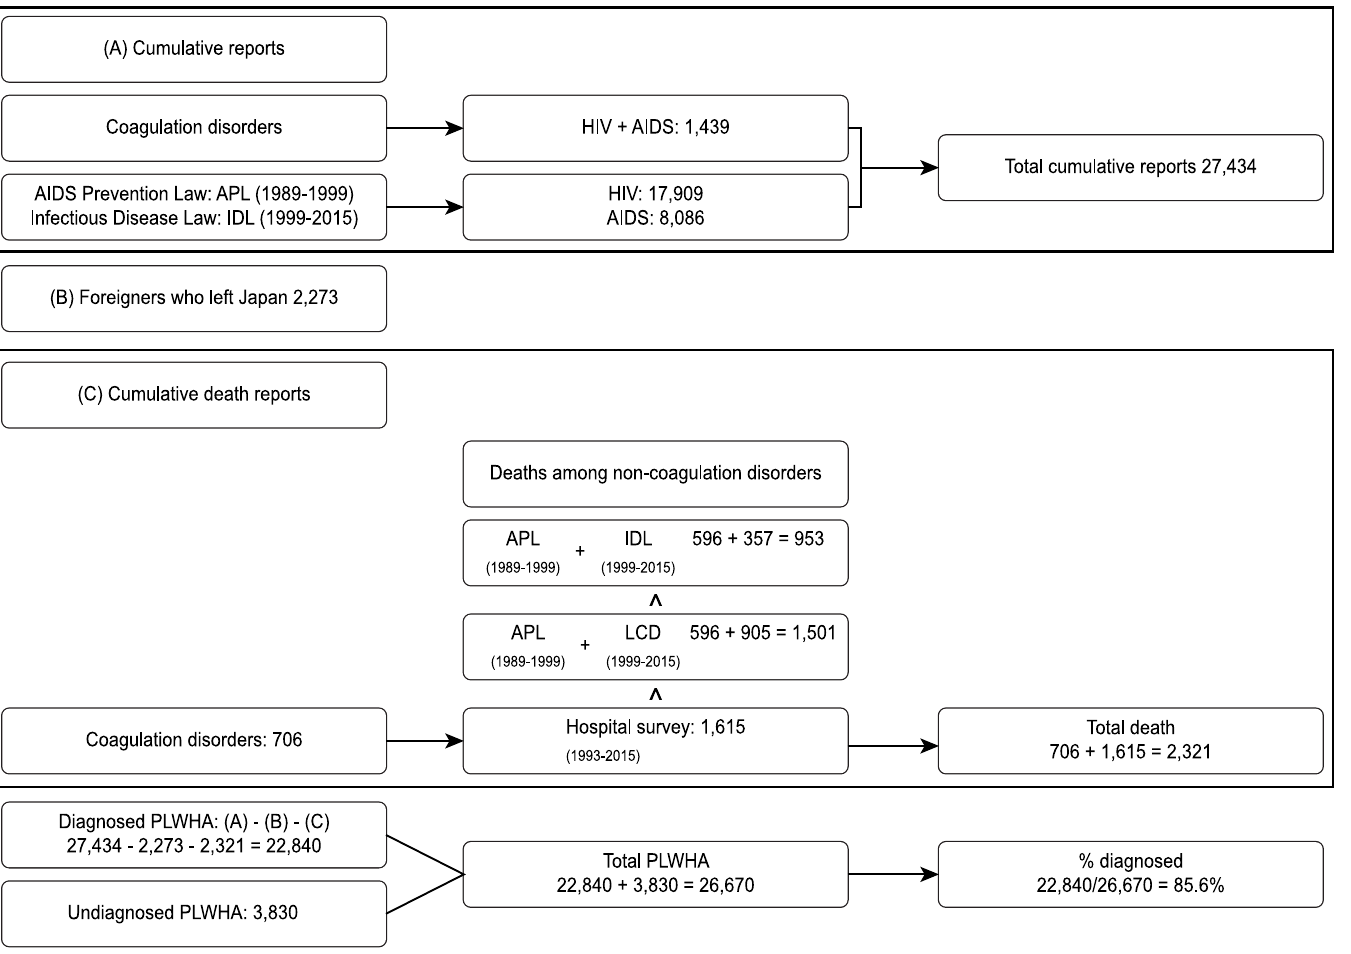
Fig 1. Estimation of diagnosed PLWHA as of December31 2015. (A)Cumulative diagnosis reports were collectedfrom different data sources. (B)The numberof foreignerswho left Japanwas estimated as written in “Materials and Methods” basedon a previousreport [27]. (C)Three different sources of deaths were available for non-coagulation disorders. The highestnumber (Hospitalsurvey) was chosen to estimate the cumulative death number. % diagnosed was calculatedbased on the data in (A), (B), (C) and the number of undiagnosed PLWHA (Table 1). APL, AIDS Prevention Law; IDL, Infectious DiseaseLaw; LCD, LeadingCause of